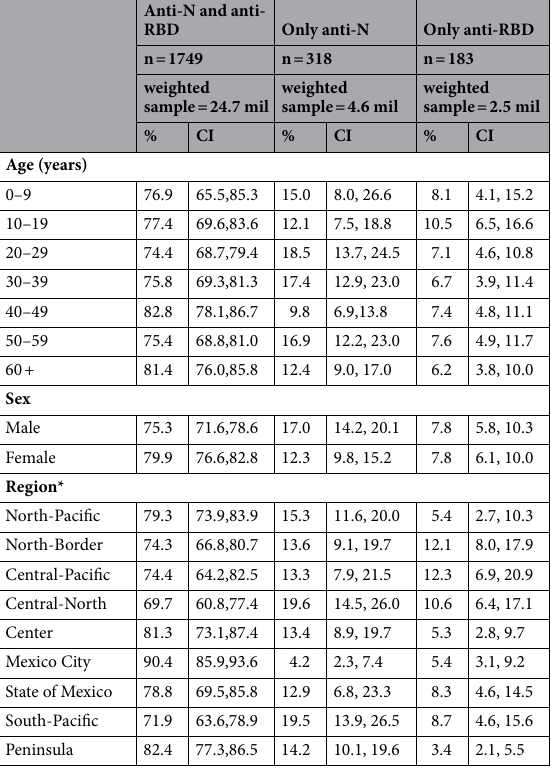
highest prevalence (12.3%, 95% CI 6.9, 20.9%) and Peninsula, the lowest (3.4%, 95% CI 2.1, 5.5%). To identify the sociodemographic factors associated with single positivity compared to double positivity we performed a multinomial logistic regression (Table 4). Females, compared to males, had 0.66 times the relative probability of being only positive to anti-N over double-positive ( p value = 0.01). Compared to Mexico City, all regions had a higher relative probability of being only positive to anti-N over double-positive and the North- Border, Central-Pacific, and Central-North had a higher relative probability of being only positive to anti-RBD over double-positive. No significant differences were observed in seropositivity to either single marker according to self-reported time post-symptom onset.